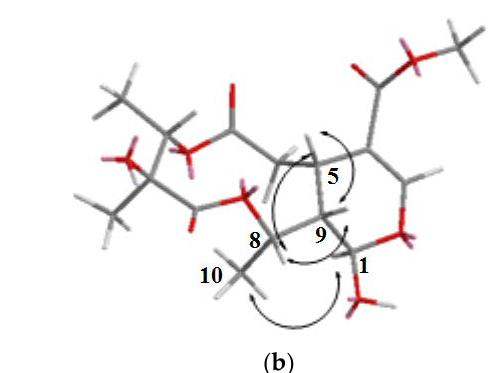
Figure 1. Chemical structures of compounds 1 – 6 .